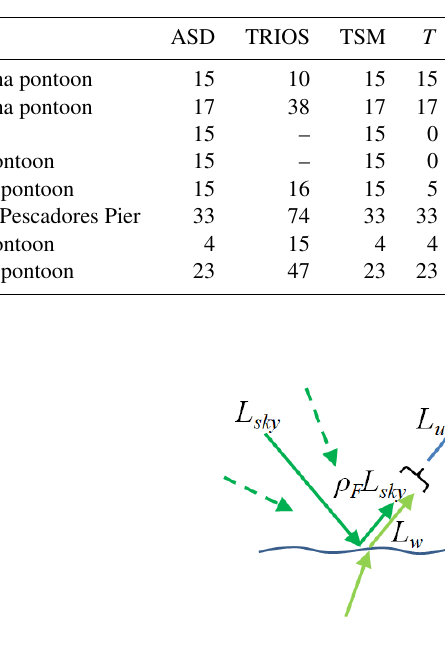
Table 2. Data collection. Campaign site location and year, type of platform used, number of radiometry (using ASD and Trios radiometers), total suspended matter, and turbidity measurements collected.